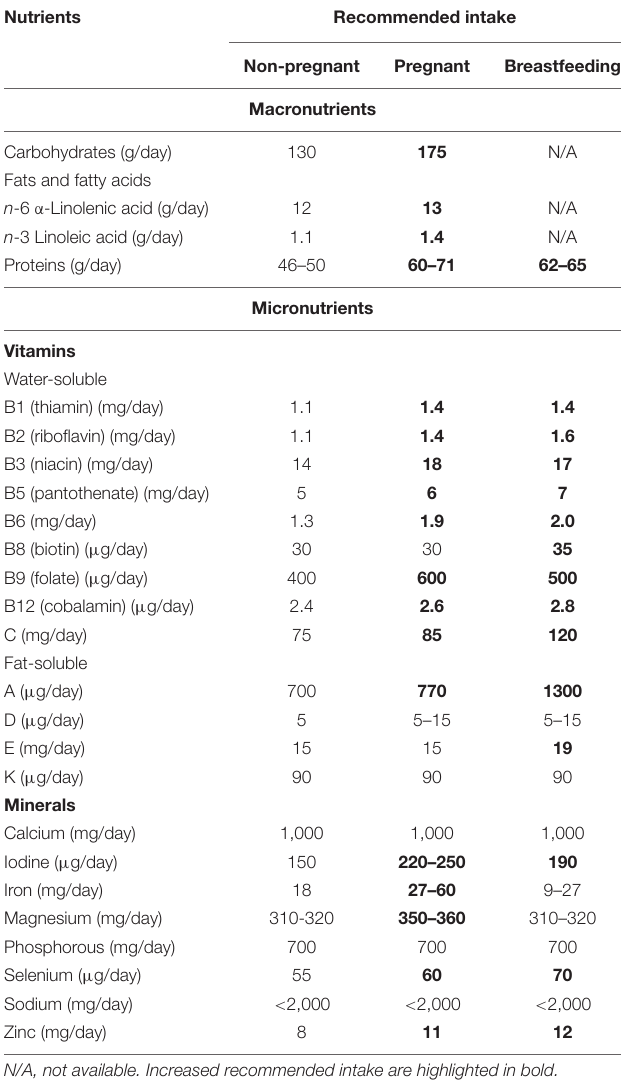
TABLE 1 | Selected macro- and micronutrients recommended daily consumption for non-pregnant, pregnant, and breastfeeding women (Katamay et al., 2007; Ares Segura et al., 2016; Kominiarek and Rajan, 2016; Mousa et al.,